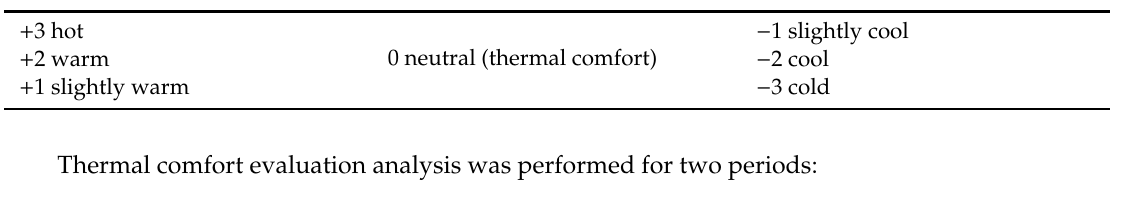
Table 1. The seven-point PMV scale by